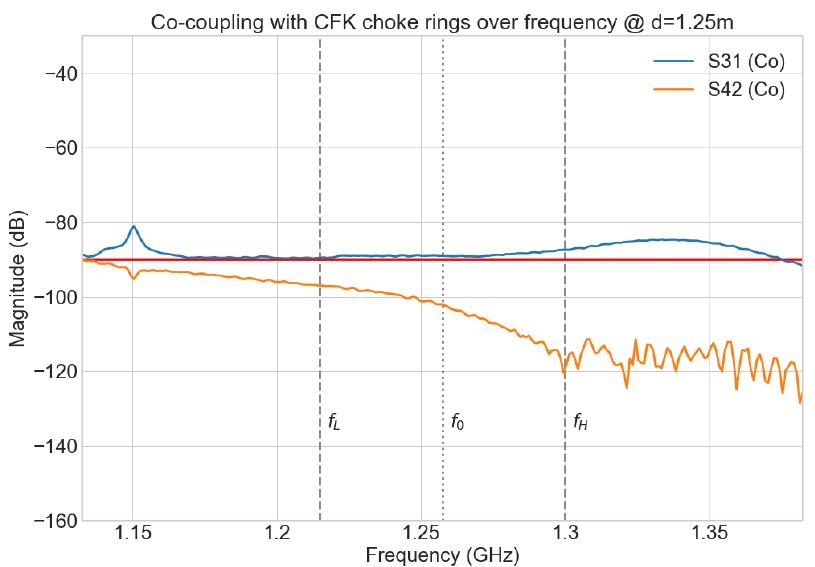
Figure 10. Measurement results for both co-coupling parameters S 31 and S 42 in dB plotted against frequency while using choke rings on both antennas. The distance between the antenna centers was set at 1.25m. As before, the relevant frequency range for the ROSE-L mission as well as the decoupling target are indicated in the